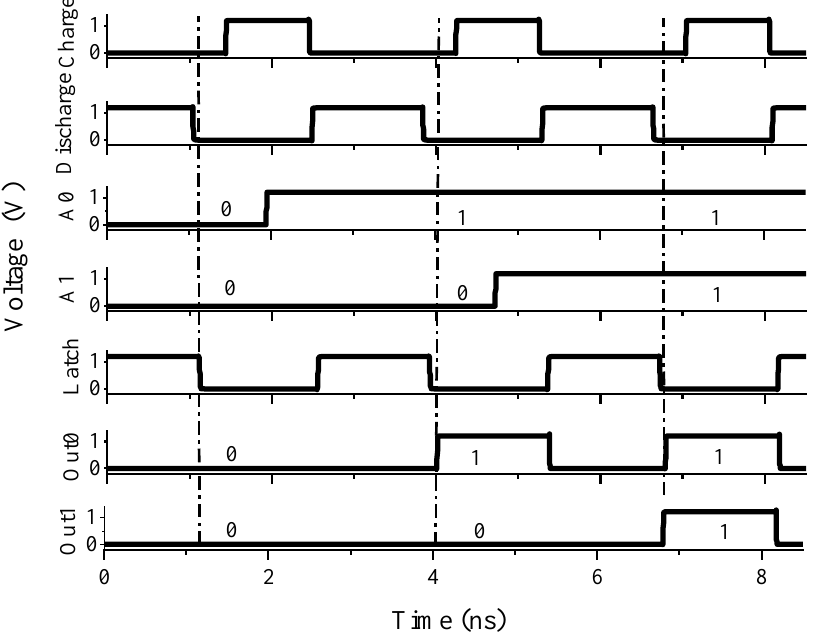
Figure 10. Transient simulation of AD1.5b considering different combinations of data inputs A 0 and A